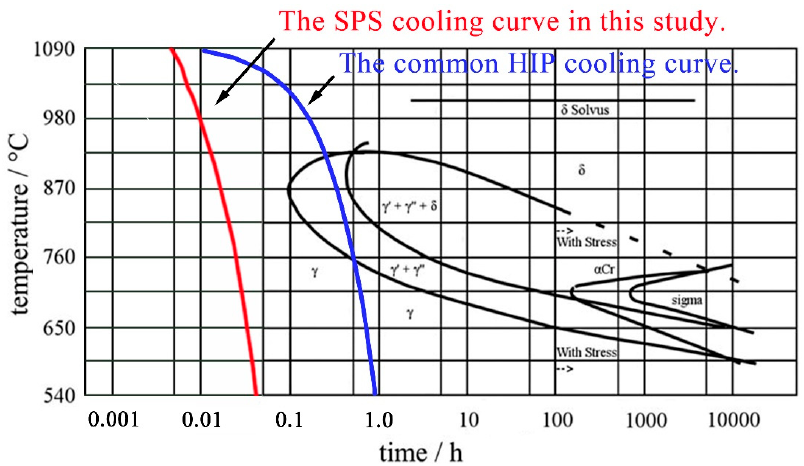
Figure 10. The time-temperature-transformation (TTT) diagram of IN718 alloy [41] with the SPS and hot-isostatic-pressing (HIP) cooling